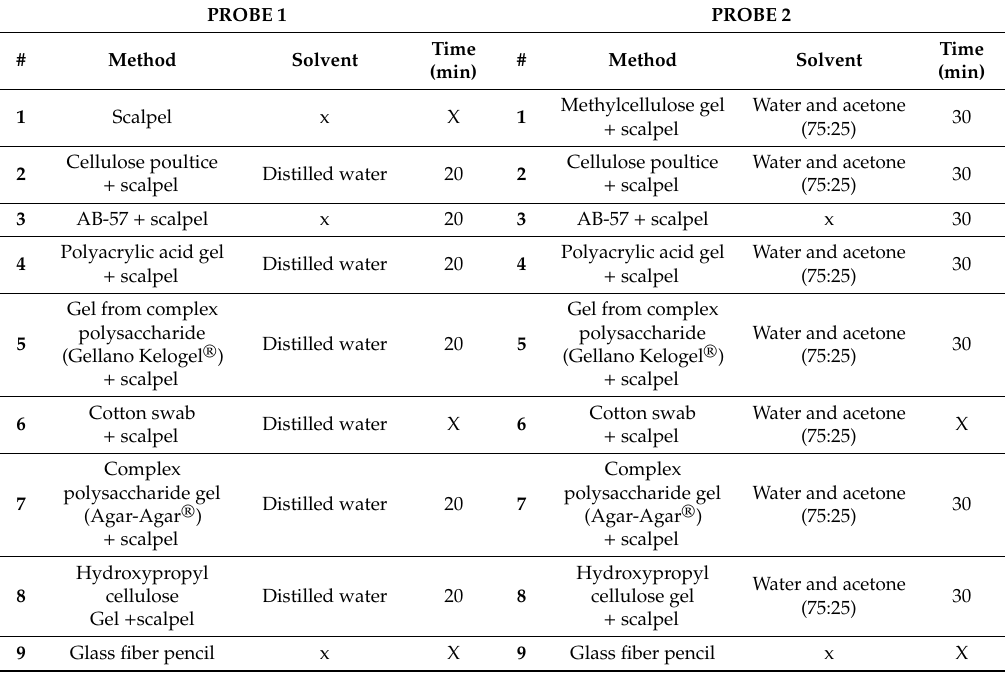
Table 1. Selected treatments for each